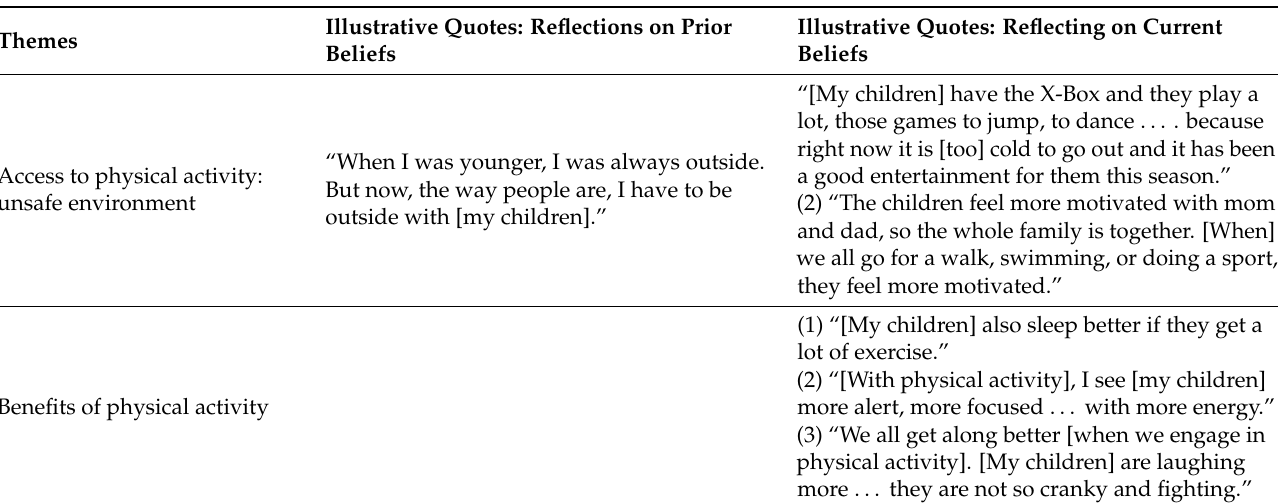
Table 5. Changes in beliefs regarding physical